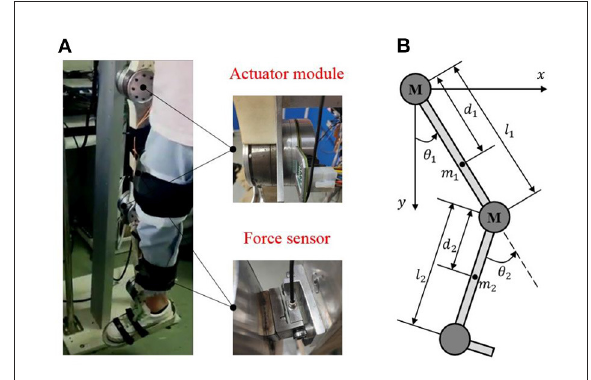
FIGURE1 The structure of the LLRR. (A) is the actual prototype of the LLRR. (B) is the simplified two-linkage model of the